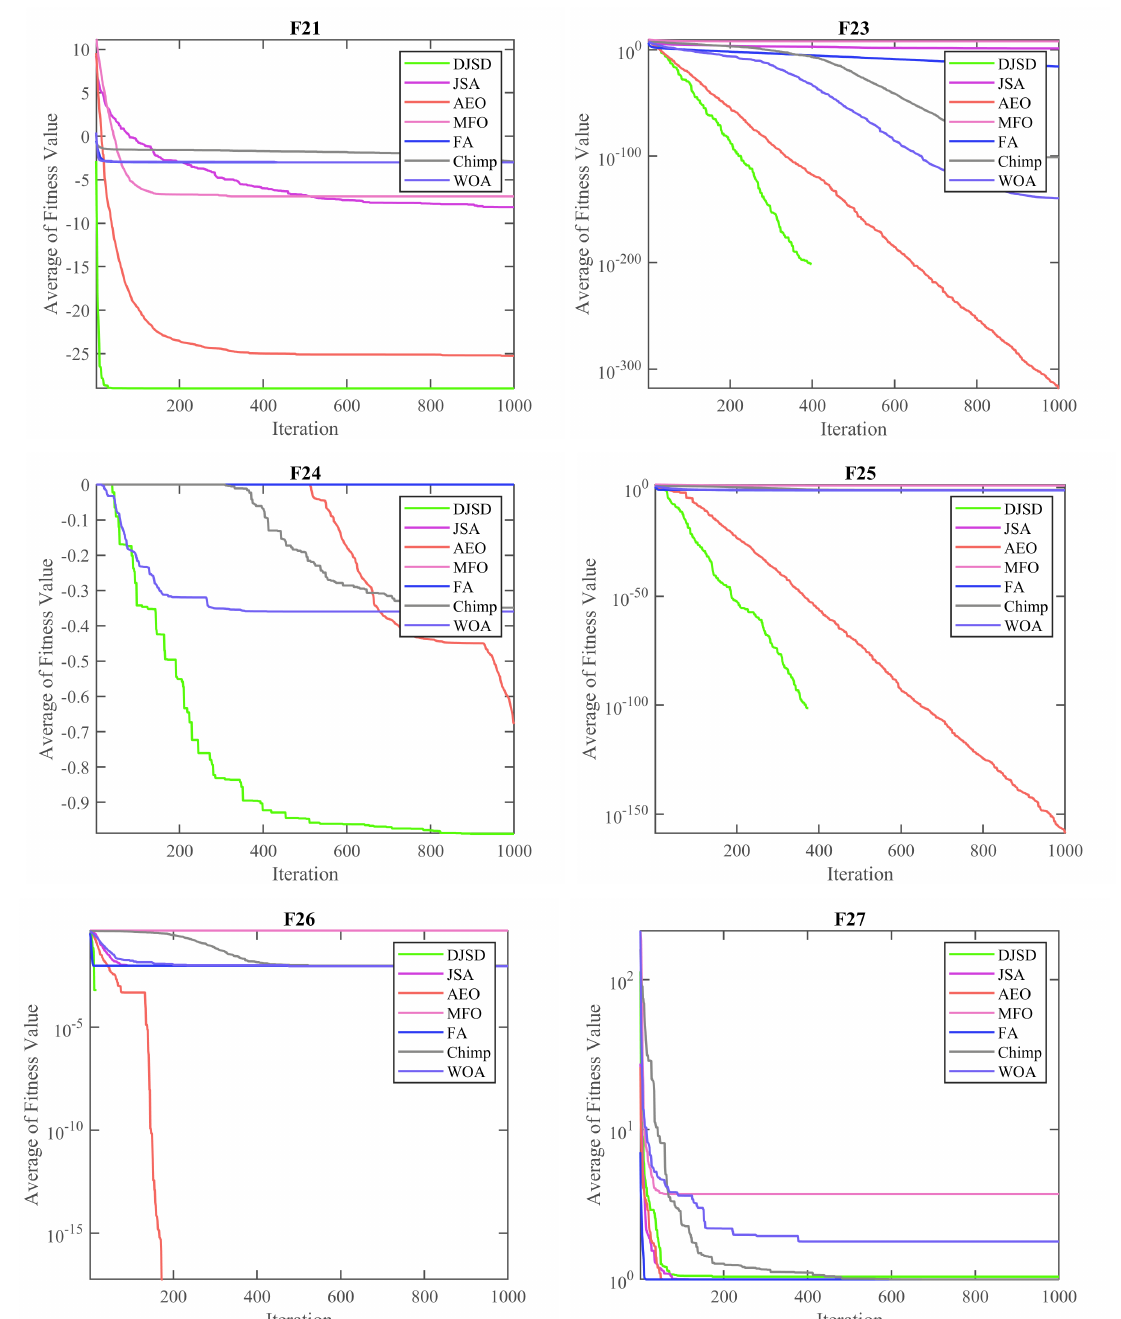
Figure 3. Convergence curves of each approach for F21, F23, F24, F25, F26, and F27. To further analyze the performance of the developed DJSD, a non-parametric test named the “Friedman test” was applied to identify whether there is a significant difference between DJSD and other MH techniques. Table 7 shows the value of the mean rank accomplished by the Friedman test for all compared techniques. It can be reported that DJSD accomplishes the best mean rank value in terms of the average, STD, and worst fitness value. However, in terms of the best fitness value, DJSD allocates the second rank behind the AEO